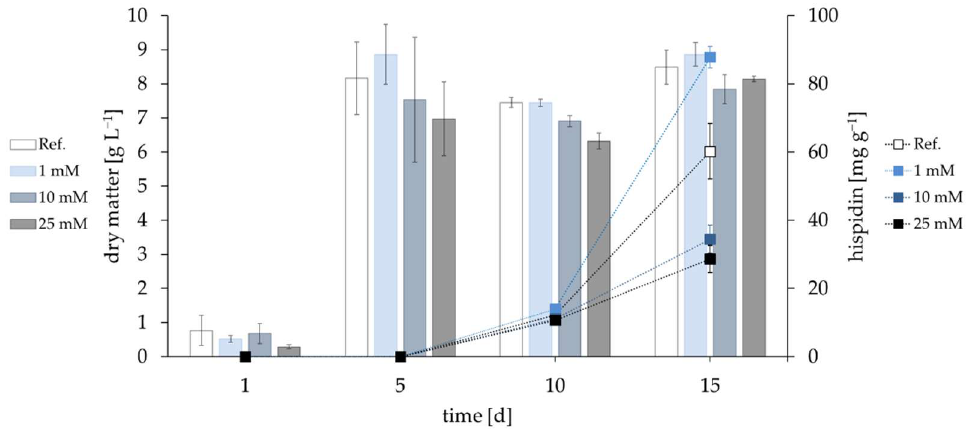
Figure 2. Biomass (bars, left ordinate) and pigment yields (squares, right ordinate) of cultures of I. hispidus exposed to oxidative stress through addition of hydrogen peroxide. The indicated concentration of H 2 O 2 was added either daily (1 mM) or once during the cultivation on day 4 (10 mM and 25 mM). As the cultivations evaluating the influences of light and oxidative stress were performed in parallel, the control in Figures 1 and 2 was